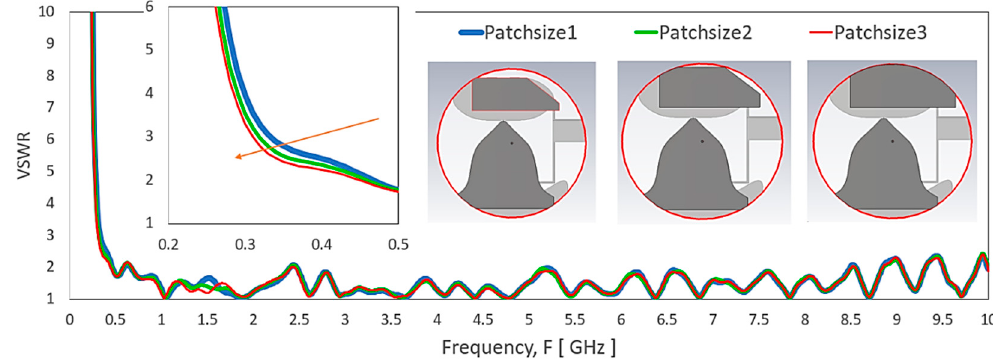
Figure 18. VSWR of the antenna by varying the proximity coupling patch to the monopole patch.